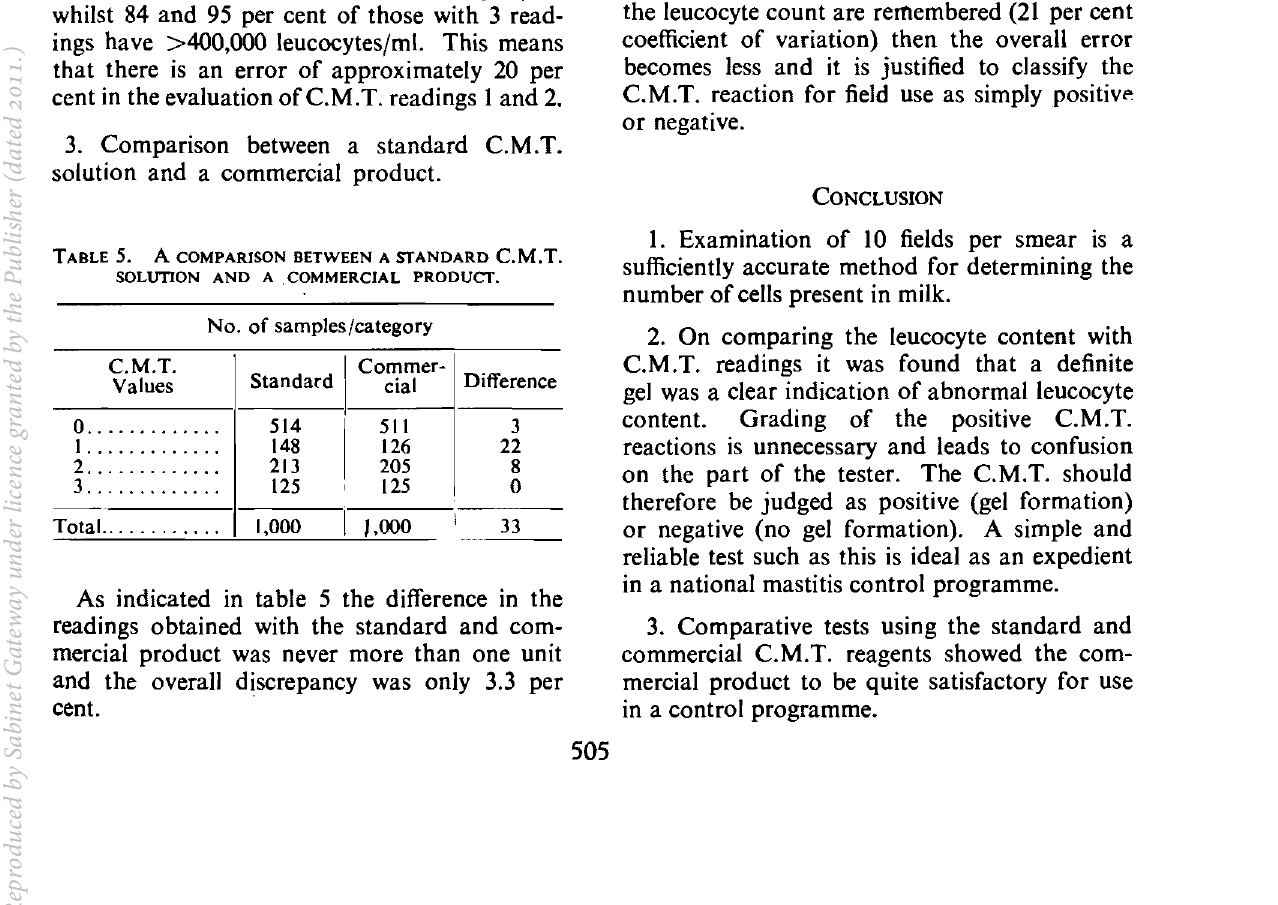
TABLE 4. PERCENTAGE C.M.T. VALUES ABOVE AND BELOW 400,000 LEUCOCYTES PER ml.